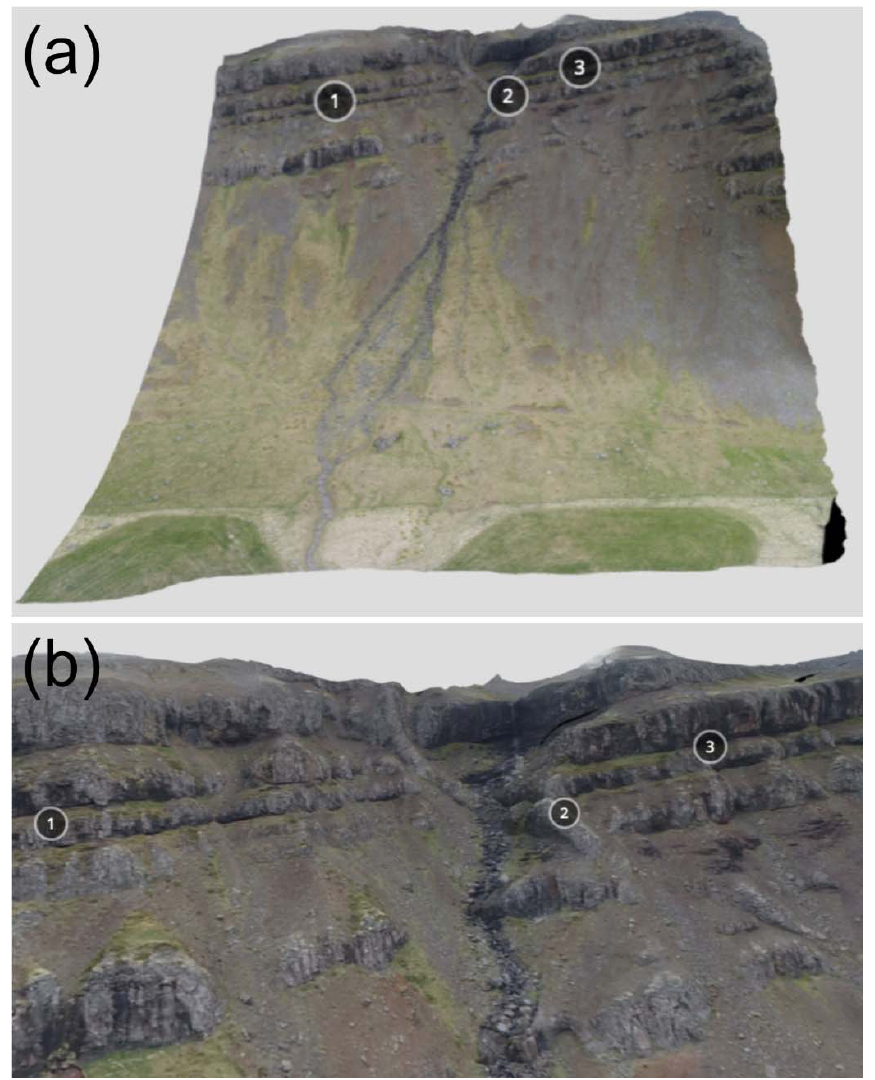
Figure 10. ( a ) Overall view of the 3D model. Numbers are interactive annotations that can be clicked online, providing the viewer with explanations about particularly relevant features. ( b ) Detail of the inclined sheet, which has intruded along a dip ‐ slip (normal) fault that has produced a downthrow of about 5 m of the lava succession to the right ‐ hand side of the model.